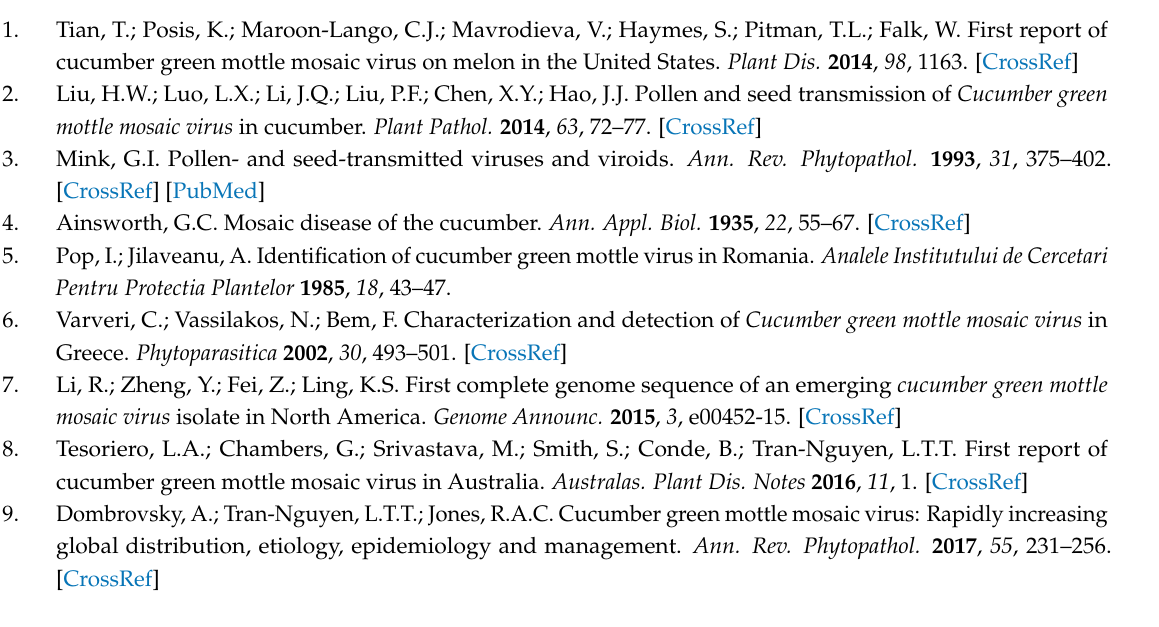
libraries. Table S2. GO term enrichment for differentially expressed genes. Table S3. KEGG pathway enrichment for differentially expressed genes. Table S4. Differentially expressed genes involved in the plant–pathogen interaction pathway. Table S5. Differentially expressed genes involved in the secondary biosynthetic pathway. Table S6. Differentially expressed genes involved in the plant hormone and signal transduction pathway. Table S7. Transcription factors involved in responses to CGMMV infection in watermelon leaves. Table S8. Primers used for qRT-PCR